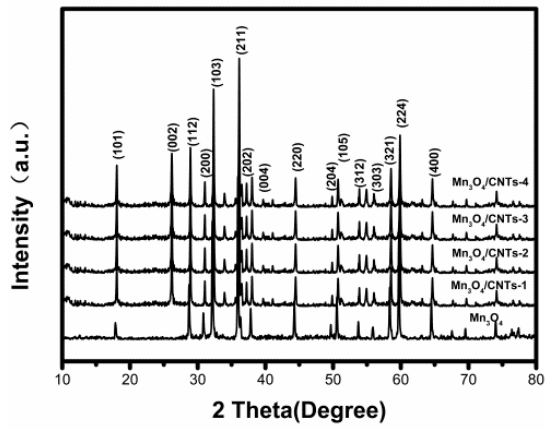
Figure 1. XRD patterns of the Mn 3 O 4 and Mn 3 O 4 /CNTs catalysts composites.